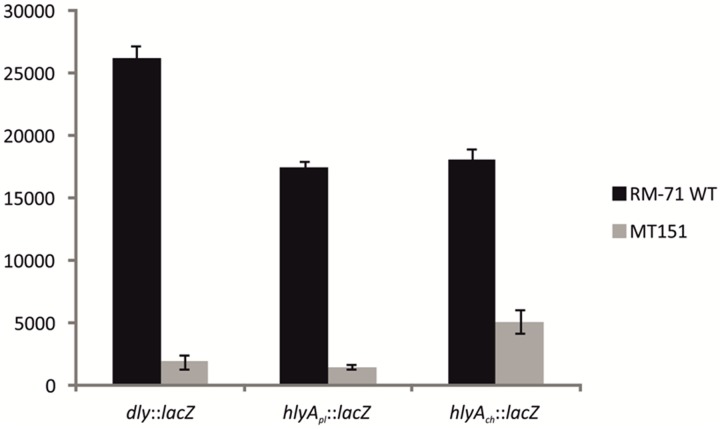
Transcriptional activity (β-galactosidase units) of the lacZ fusions to the dly, hlyApl, and hlyAch promoters, under parental (RM-71) and ΔrstB mutant (MT151) backgrounds. All experiments were carried out in triplicate. Mean values with standard deviations denoted by error bars are shown.